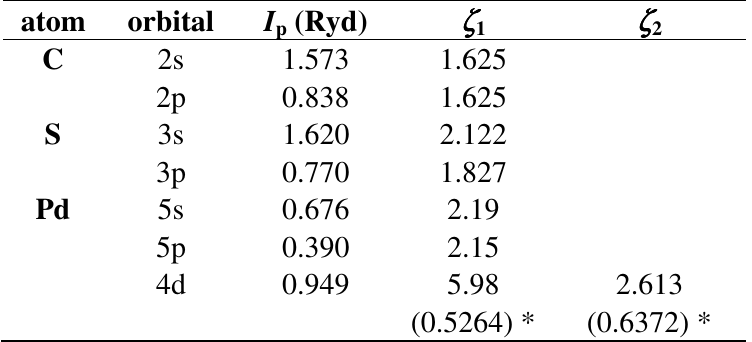
Table 4. Semi-empirical parameters for Slater-type atomic